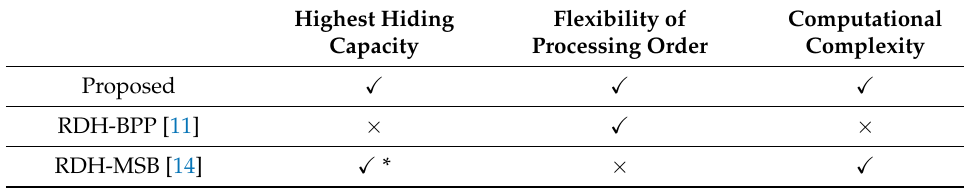
Table 3. Performance comparison among proposed method and related work [11,14].